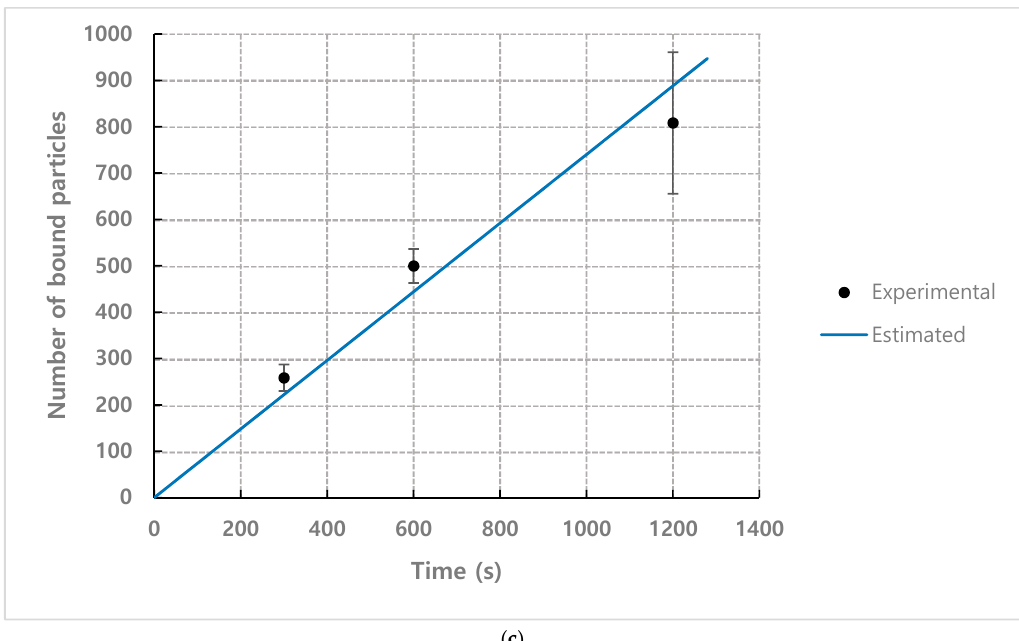
Figure 14. Comparison for number of bound particles from experiment and mathematical model (Equation (7)) depending on time for di ff erent flow rate condition ( a ) flow rate = 0.3 mL · h − 1 , ( b ) flow rate = 1.2 mL · h − 1 , ( c ) flow rate = 2.4 mL · h − 1 ( n = 1.93 × 10 14 m − 3 , observation position = 35 mm). Solid lines depict data fitting with Equation (7). Coe ffi cients of determination are ( a ) R 2 = 0.98, ( b ) R 2 = 0.98, ( c ) R 2 = 0.93 .